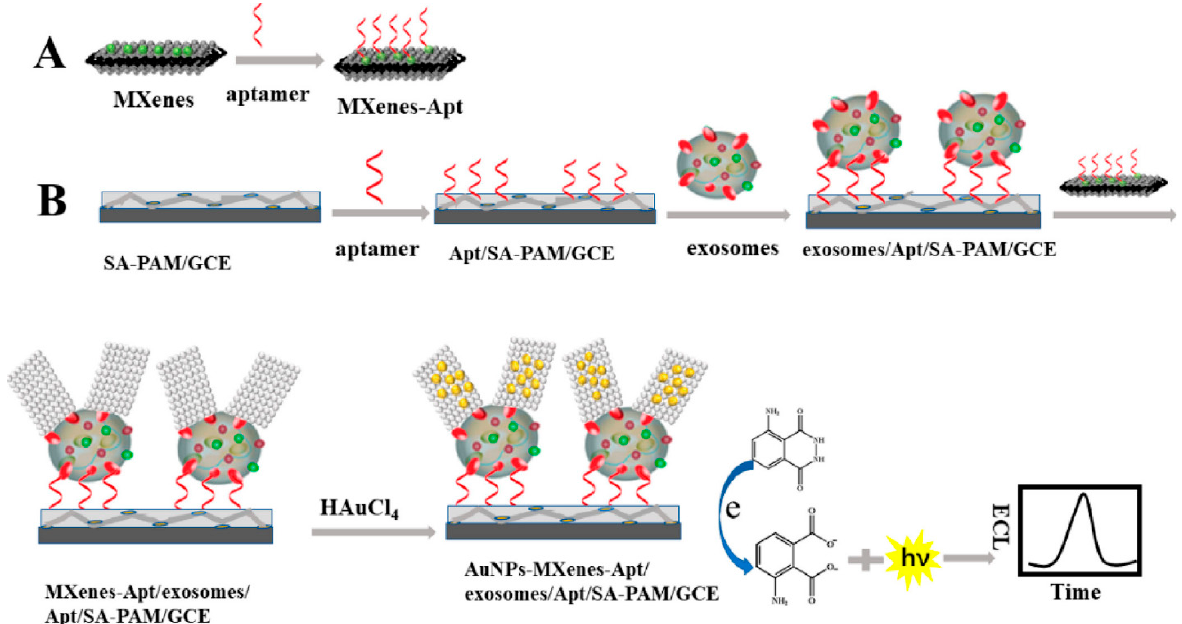
Figure 9. Principle of the ECL biosensor for the detection of exosomes with respect to in situ formation of AuNPs decorated Ti 3 C 2 MXenes nanoprobes. Adapted from Ref. [114] with authorisation of ©2020 American Chemical Society.